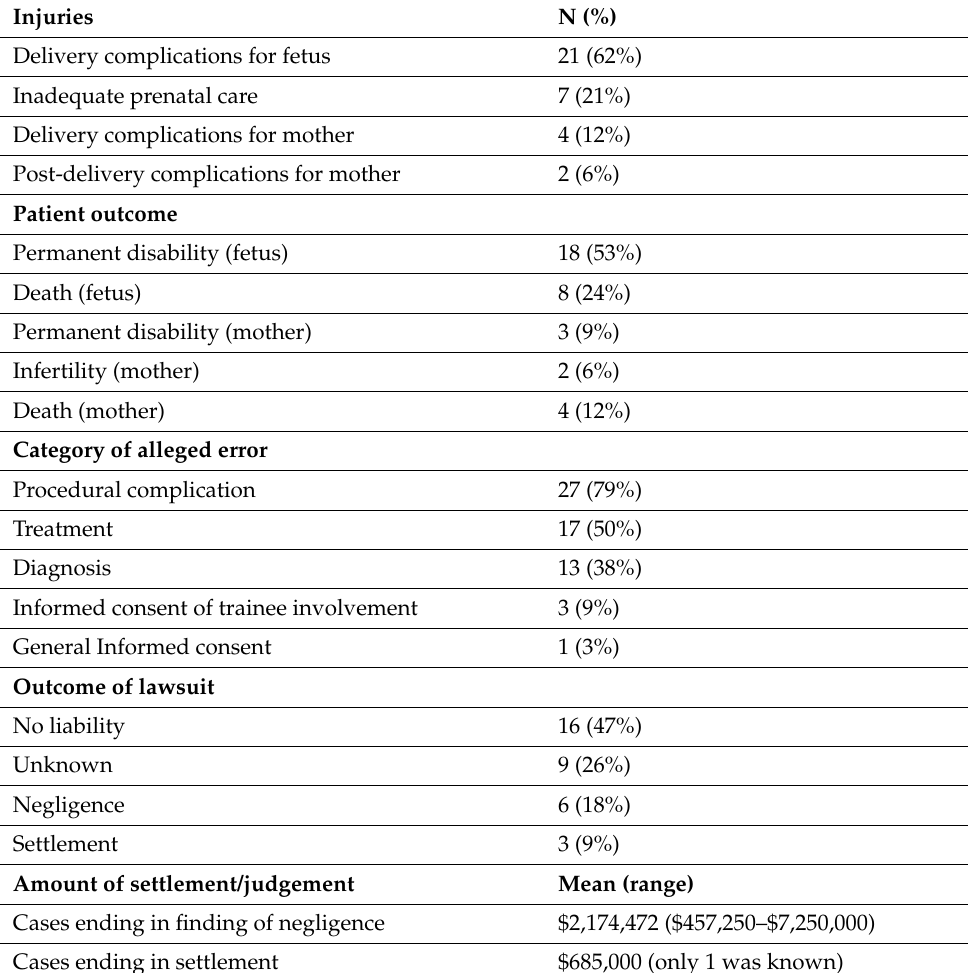
Table 1. Characteristics of 34 legal cases involving trainees in obstetrics.